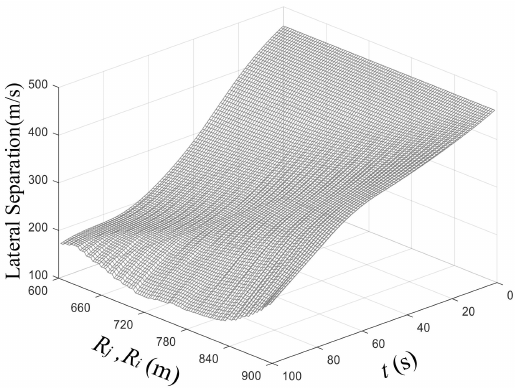
Figure 6. Trend Chart of Lateral Separation between Two Aircraft with Time and Visual Range.